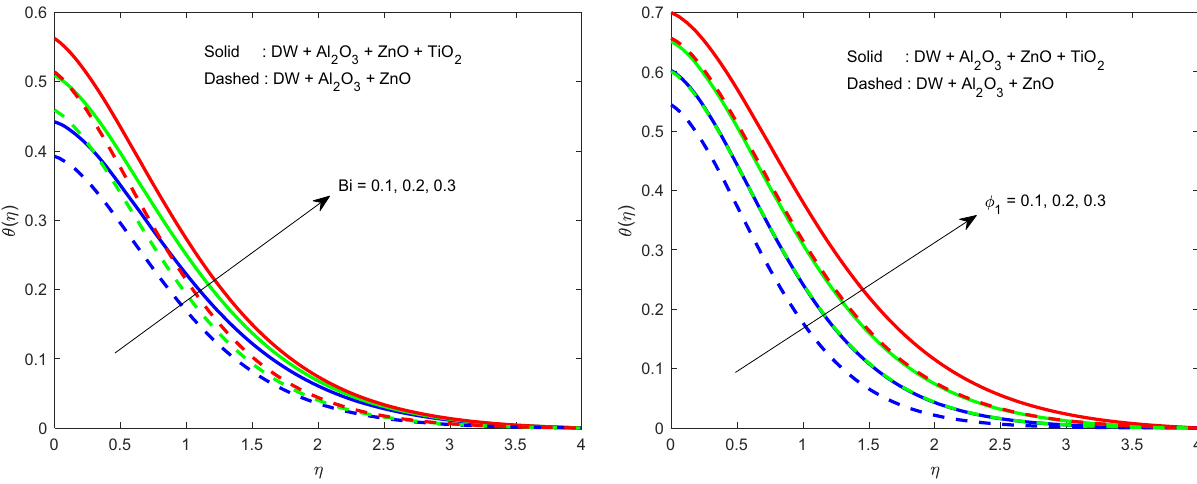
Figure 5: Increasing e ff ects of Bi on θ ( η ) .